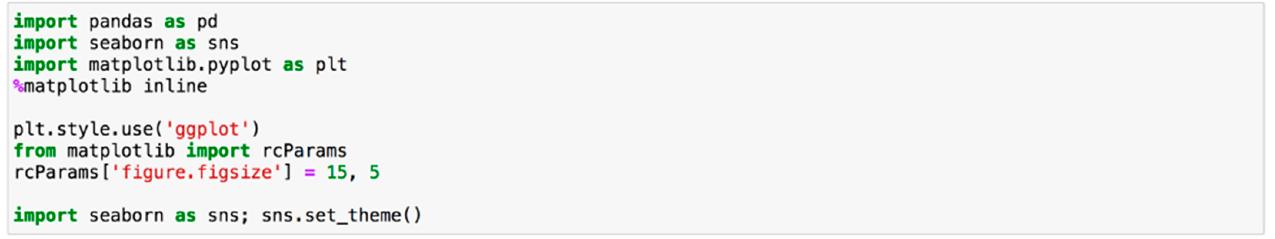
Figure 4. Import required in Python Libraries .